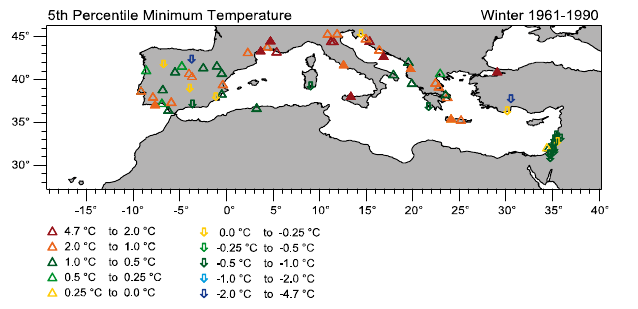
Figure 3: Trends of the 95 th percentile of maximum temperature in summer (June to August) for the period 1961-1990. Colour-filled symbols indicate significant trends at the 90% level.